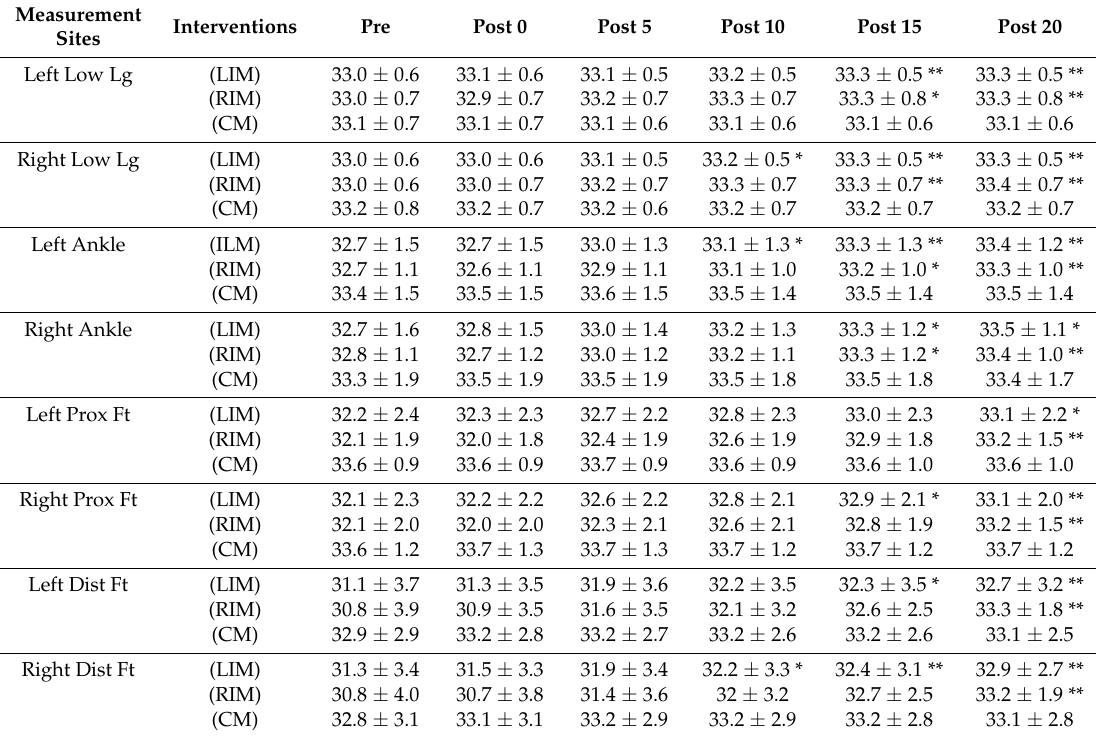
Table 1. Skin temperature responses before and after indirect moxibustion (IM) to the left leg (LIM), right leg (RIM), and control group